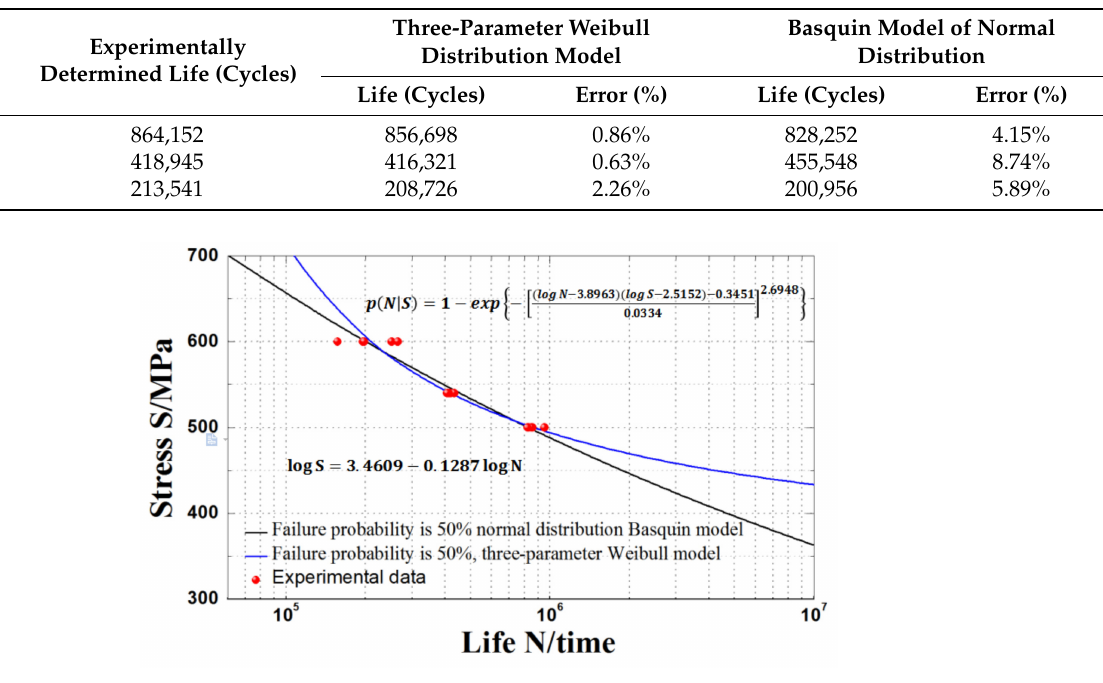
Figure 8. Comparison of S - N curve fitting results of HL-type ultra-high strength sucker rod obtained from the two